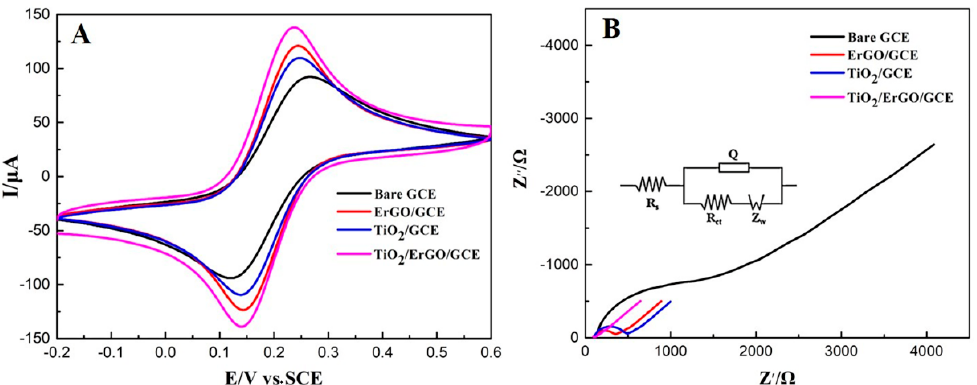
Figure 2. Cyclic voltammograms ( A ) and Nyquist plots ( B ) recorded at various electrodes in 0.1 M